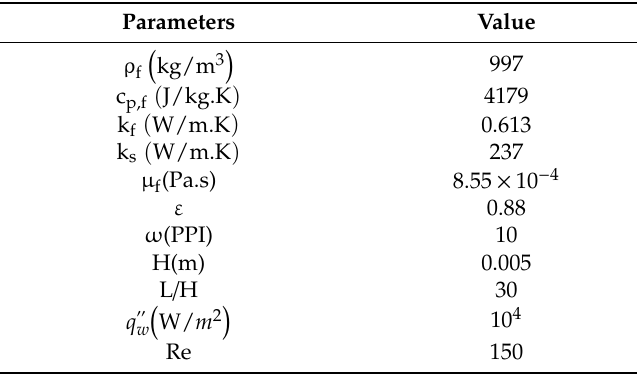
Table 3. Input parameters used in the numerical